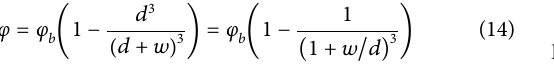
Frontiers in Earth